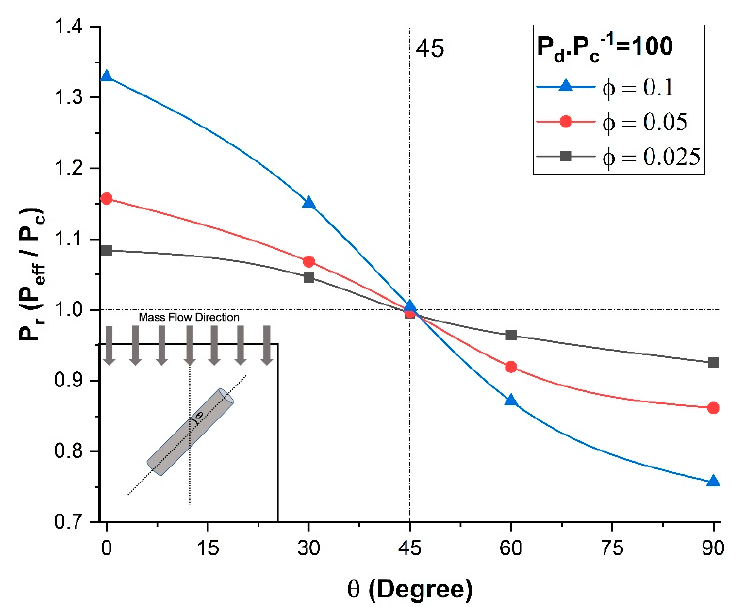
Figure 5. Relative permeability for different nanotube orientations and volume fractions at P d / P c = 100 and α = 10.